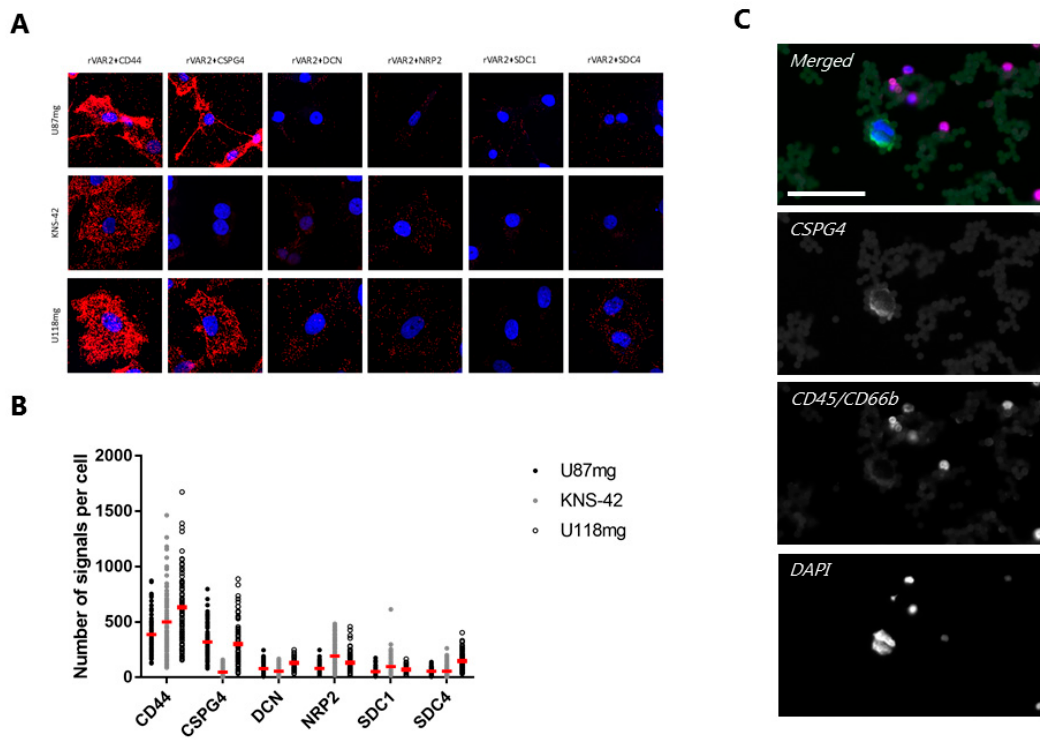
Figure 3. Evaluation of protein pull-down hits from mass spectrometry by proximity ligation assay (PLA). ( A ) Representative images of PLA assays on U87mg, KNS-42, and U118mg cells showing co-localization between rVAR2 and a panel of CSPGs as red dots. Cells were counterstained with DAPI (blue) and analyzed by confocal microscopy. All of the images are shown in same magnification using a 60 × objective. ( B ) Quantification of the PLA co-localization signals between rVAR2 and each of the CSPGs analyzed. Data is shown as the number of signals per cell. Red bars represent the mean number of signals per cell. ( C ) Representative image showing specific CSPG4 staining (green) of an rVAR2-captured U87mg cell in a background of WBCs stained for CD45 and CD66b (both red). Cells were stained with DAPI (blue) and visualized on the Cytation 3 Imager with a 20 × objective. Scale bar, 50 µm.